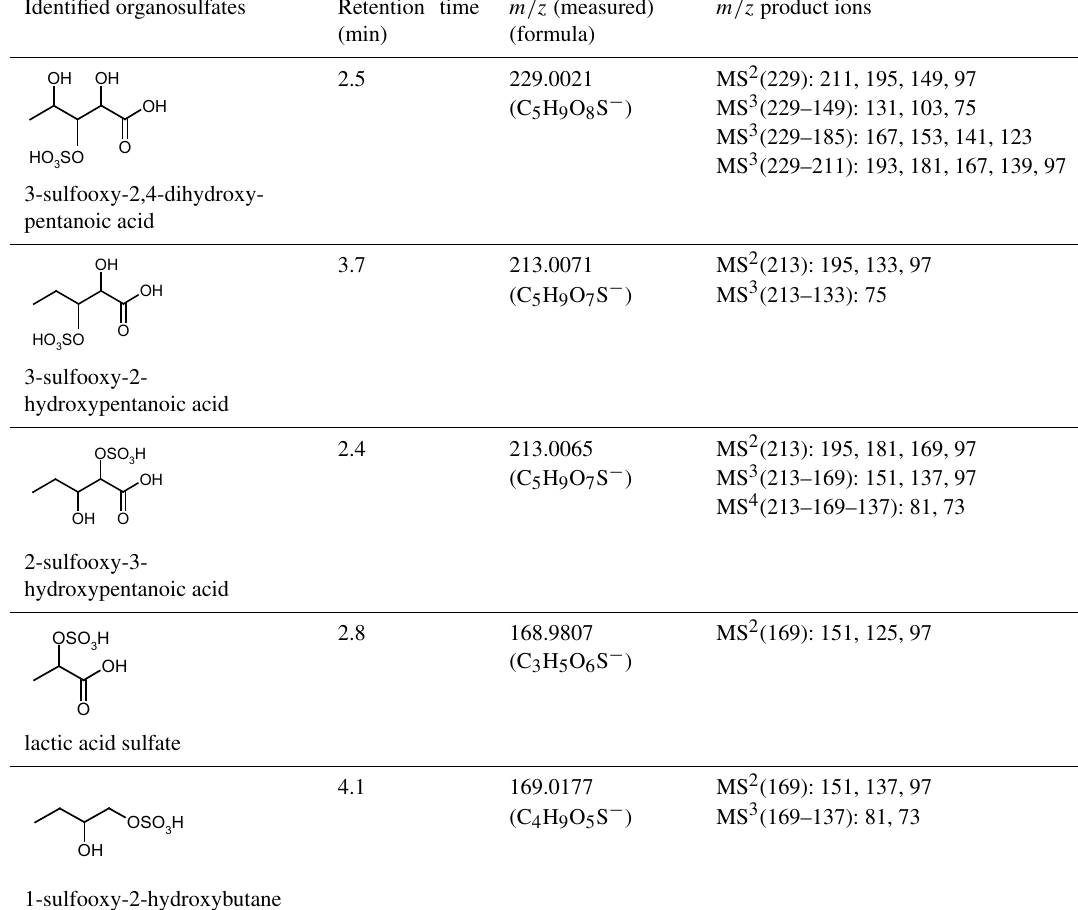
Table 2. Tentatively identified organosulfates with chromatographic and mass spectral data (retention time, m/z , elemental formula, and m/z of main product ions). The retention times are given for the compounds identified in SOA. Identified